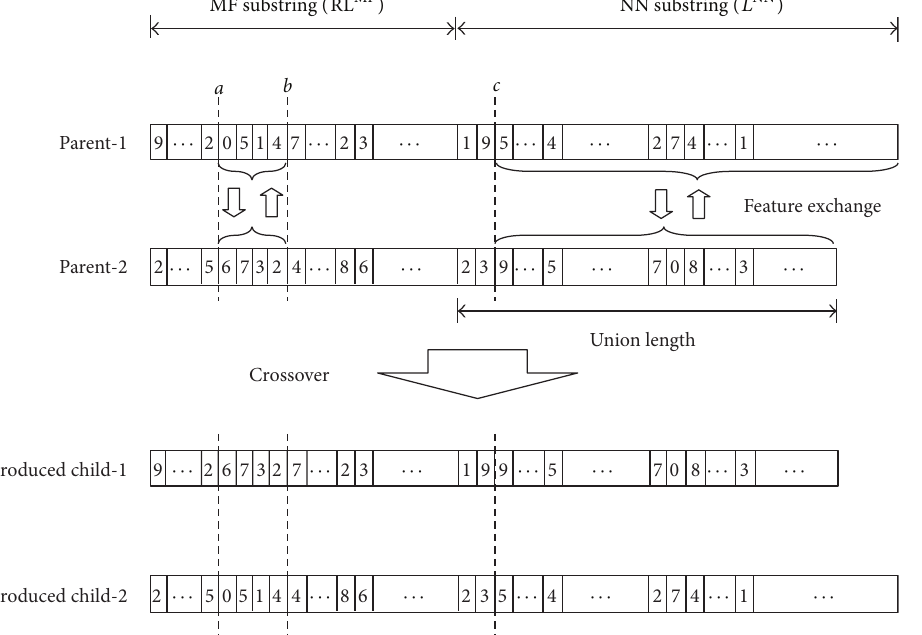
Figure 7: Three-cut-points crossover.